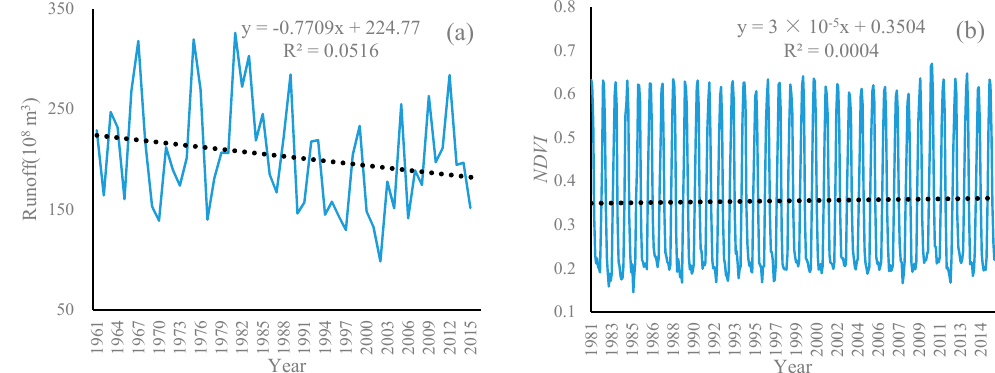
Figure 2. Change trend of annual average runoff from 1961 to 2015 ( a ) and NDVI ( b ) from 1981 to 2015 in the source area of the Yellow River basin.